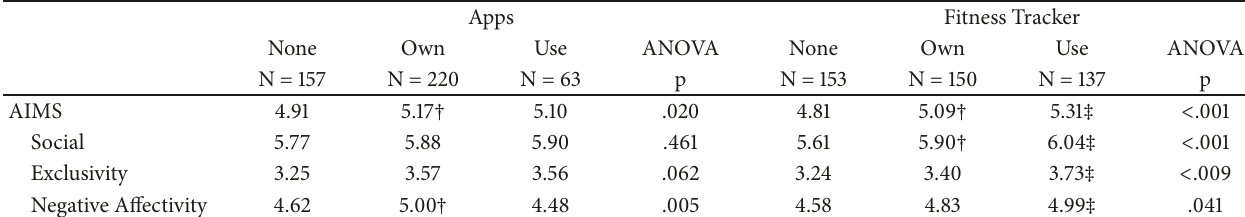
Table 4: Mean scores of athletic identity of apps and fitness tracker